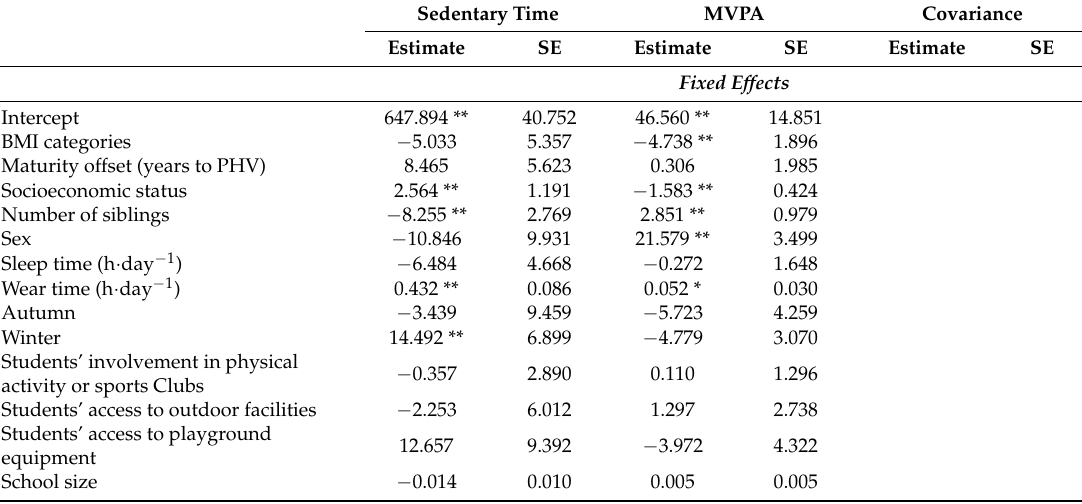
Table 5. Model 3 (parameter estimates, Standard Errors (SE), and deviance) including child and school level predictors for both sedentary time and